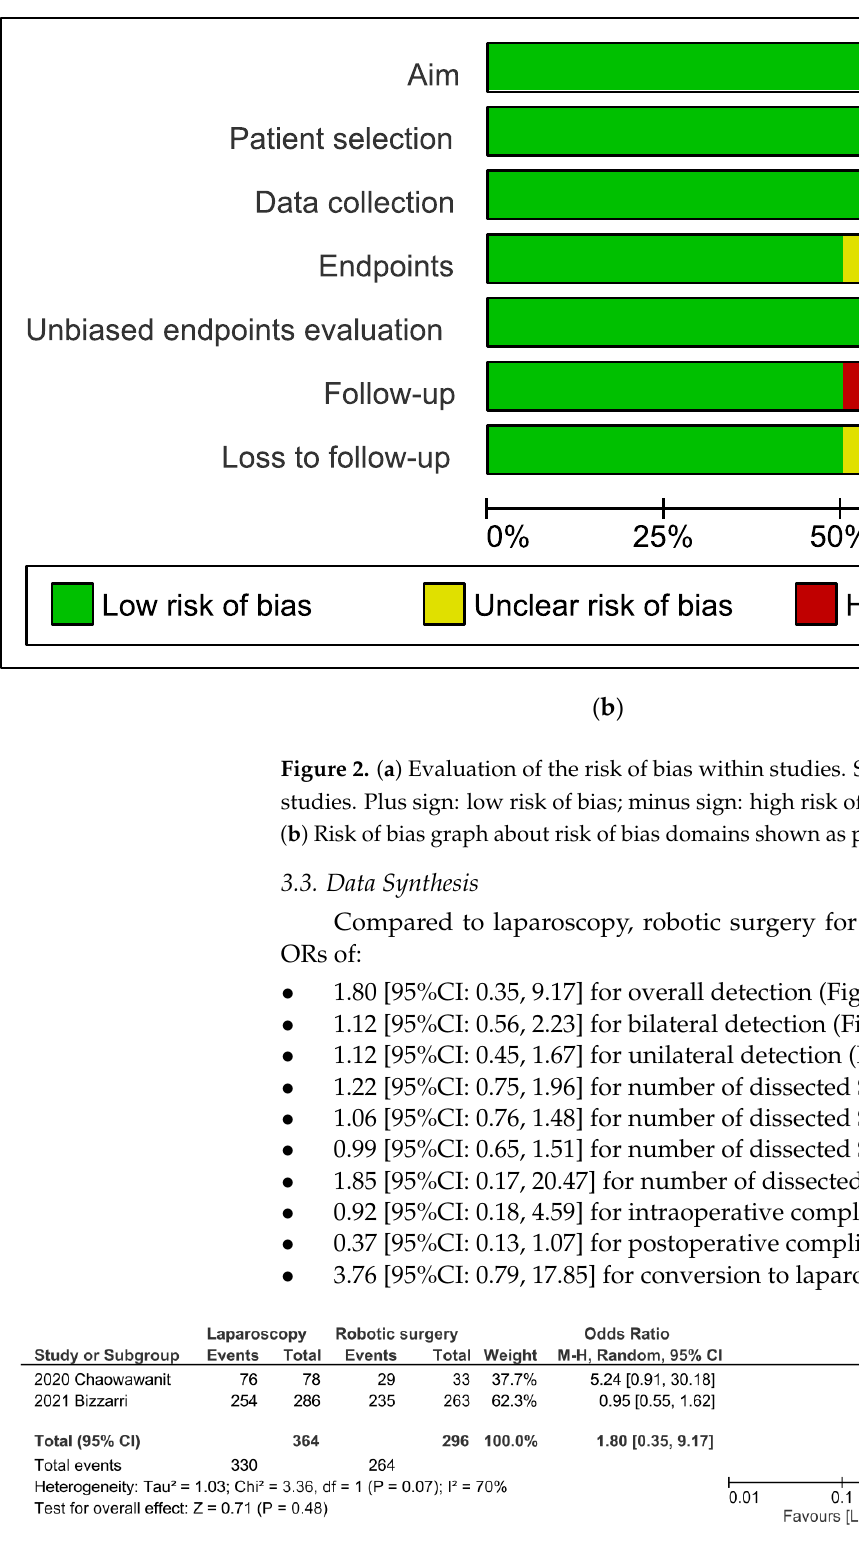
Figure 3. Forest plot of individual and pooled odds ratios, with 95% confidence interval (CI), for overall detection, comparing laparoscopy and robotic surgery for SLN biopsy in EC women.